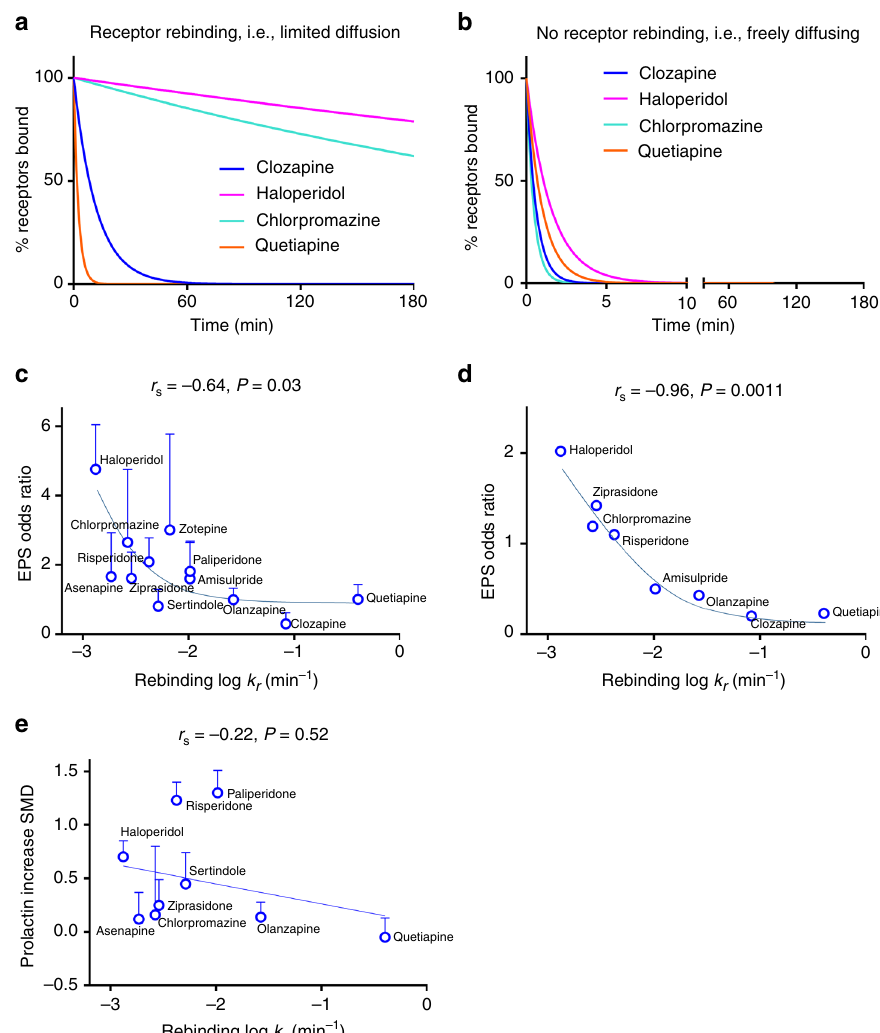
Fig. 4 Modeling APD D 2 R rebinding and its consequences for clinical “ on-target ” toxic effects. Simulated dissociation rates of clinically relevant APs to human D 2 R, a under conditions of limited diffusion based on the association ( k on ) and dissociation ( k off ) rates determined in competition kinetic binding experiments, b under condition of free diffusion based on measured off rates ( k off ) determined in competition kinetic binding experiments. All kinetic parameters used to these plots are detailed in Table 1 and in the methods section associated with Eq. (4). For simulation purposes, the reversal rate k r was based on the model of an immunological synapse as detailed in the “ Methods ” section. Correlating clinical “ on-target ” effects with the kinetically derived overall reversal rate k r . Correlation plot showing the relationship between c log k r and EPS odds ratio, taken from Leucht et al. 31 Correlation plot showing the relationship between d log k r and EPS odds ratio (relative to placebo or baseline conditions, averaged across studies), taken from studies of early psychosis patients 50 – 57 . Correlation plot showing the relationship between e log k r and prolactin increase, taken from Leucht et al. 31 All kinetic data used in these plots are detailed in Table 1. Kinetic data are presented as mean ± s.e.m. from four experiments and clinical data as standardized mean difference (SMD) for prolactin increase and odds ratio for EPS with associated credible intervals where indicated. The relationship between two variables was assessed using a two-tailed Spearman ’ s rank correlation allowing the calculation of the correlation coef fi cient, r s . A P value of 0.05 was used as the cutoff for statistical signi fi cance and relationships depicted as trend